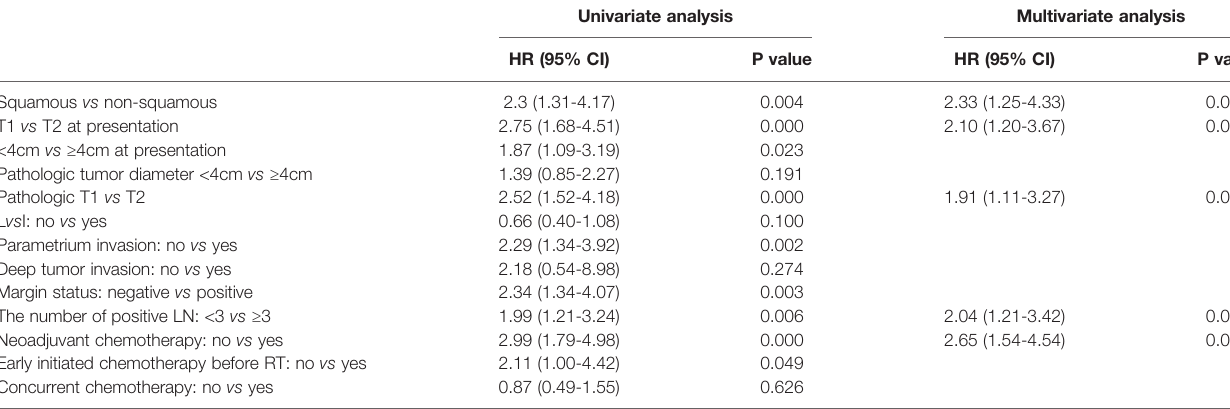
TABLE 2 | Factors predicting disease-free survival in LN involved early-stage cervical cancer.